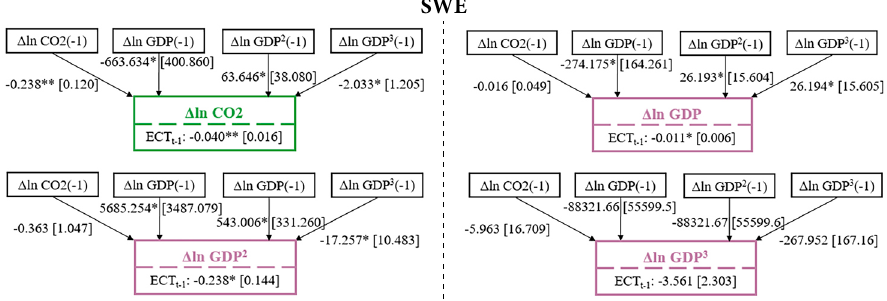
Figure 7. Granger causality test results – cubic